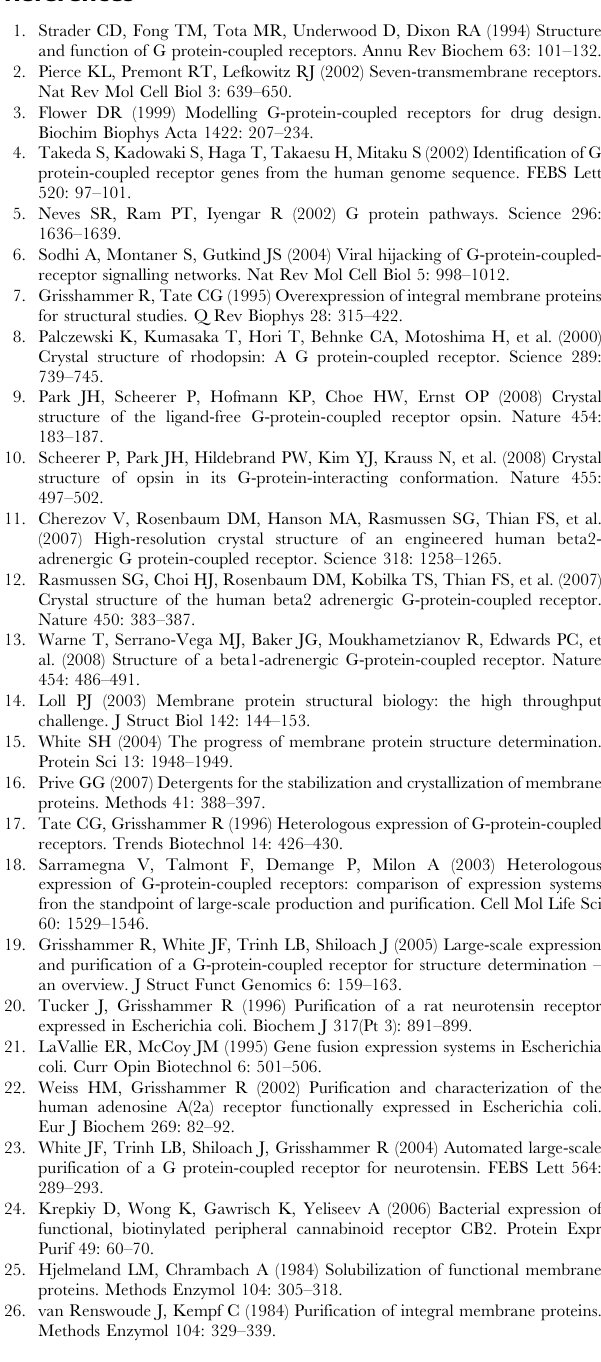
Figure S1 Codon-optimized DNA sequences of human chemo- kine receptors CCR5, CCR3, CXCR4 and CX3CR1. Found at: doi:10.1371/journal.pone.0004509.s001 (0.04